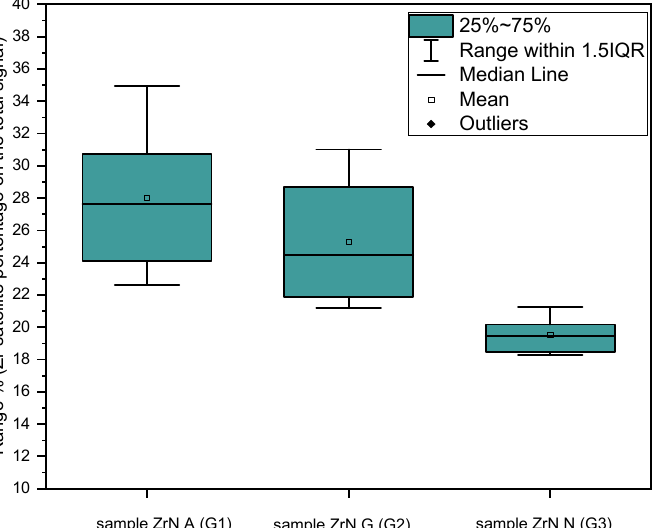
Figure 12. Histogram of Zr 3d satellite comparison among three representative samples A, G and N.